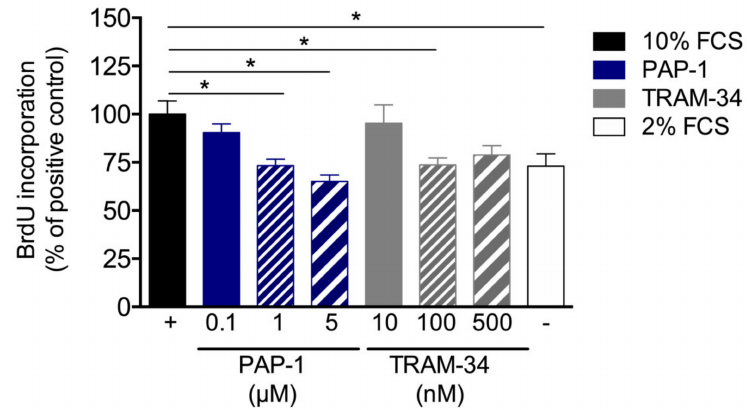
Figure 7. Proliferation assay of mouse primary artery SMCs. Mouse primary artery SMCs were cultured with 10% FCS with or without treatment of di ff erent concentrations of the K V 1.3 blocker PAP-1 or the K Ca 3.1 blocker TRAM-34. Cell proliferation was investigated by means of BrdU incorporation. Values are expressed as percentages of the positive control ( + ), i.e., mouse primary artery SMCs stimulated with 10% FCS. For the negative control (–), mouse primary artery SMCs cultured with 2% FCS. Data are means ± SEM, n > 6 per group. * p < 0.05 from one-way ANOVA with Bonferroni’s multiple comparison